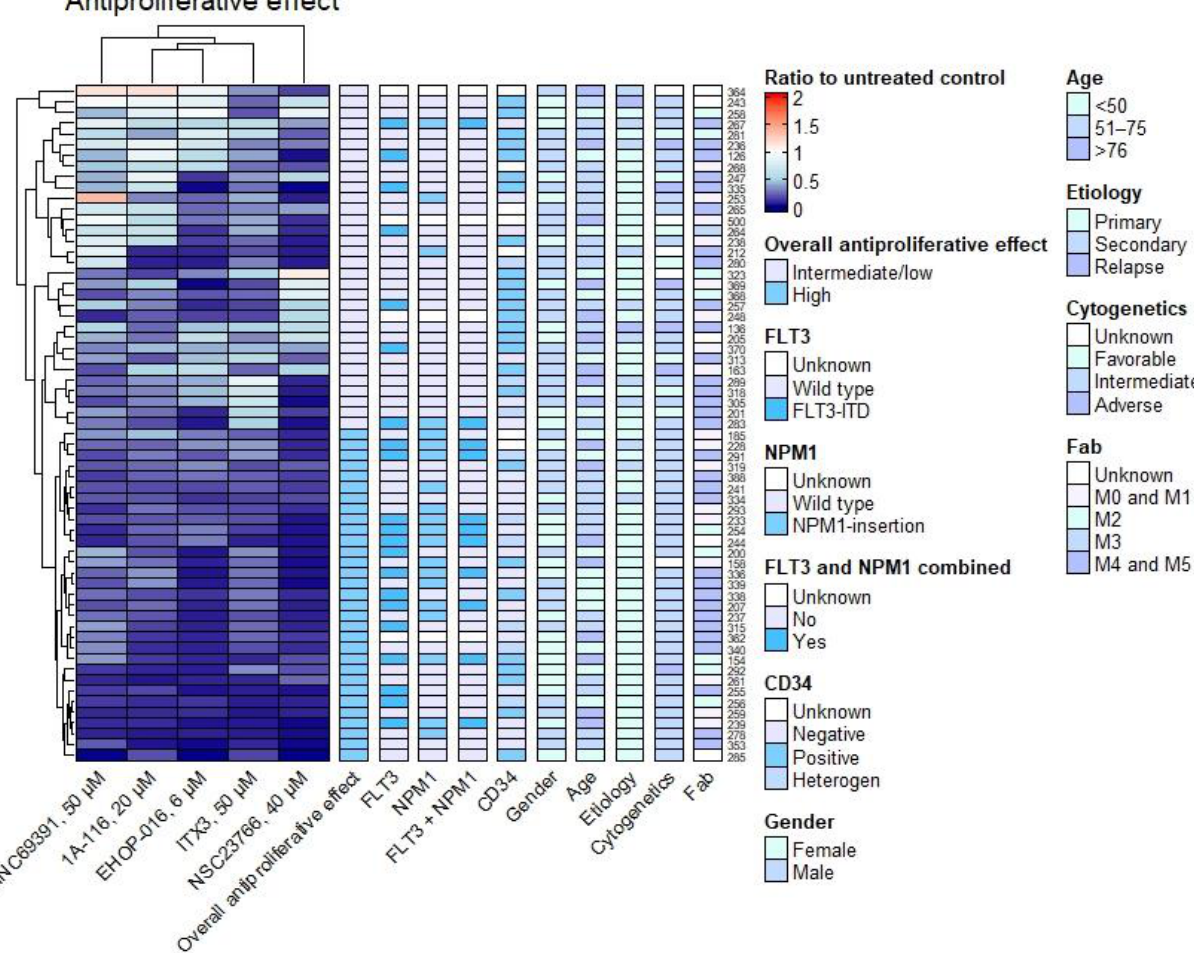
p = 0.024). There were no significant associations with NPM1 mutation, FLT3 mutation, FAB classification, or overall antiproliferative effect by the 3 H-Thymidine proliferation